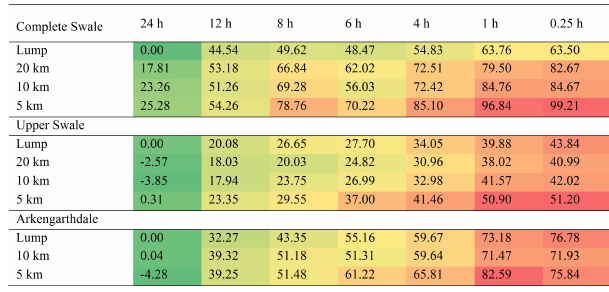
Table 9. The percentage deviations for each catchment of the vol- ume of sediment yield outputs above the 95th percentile using dif- ferent spatio-temporal resolutions.